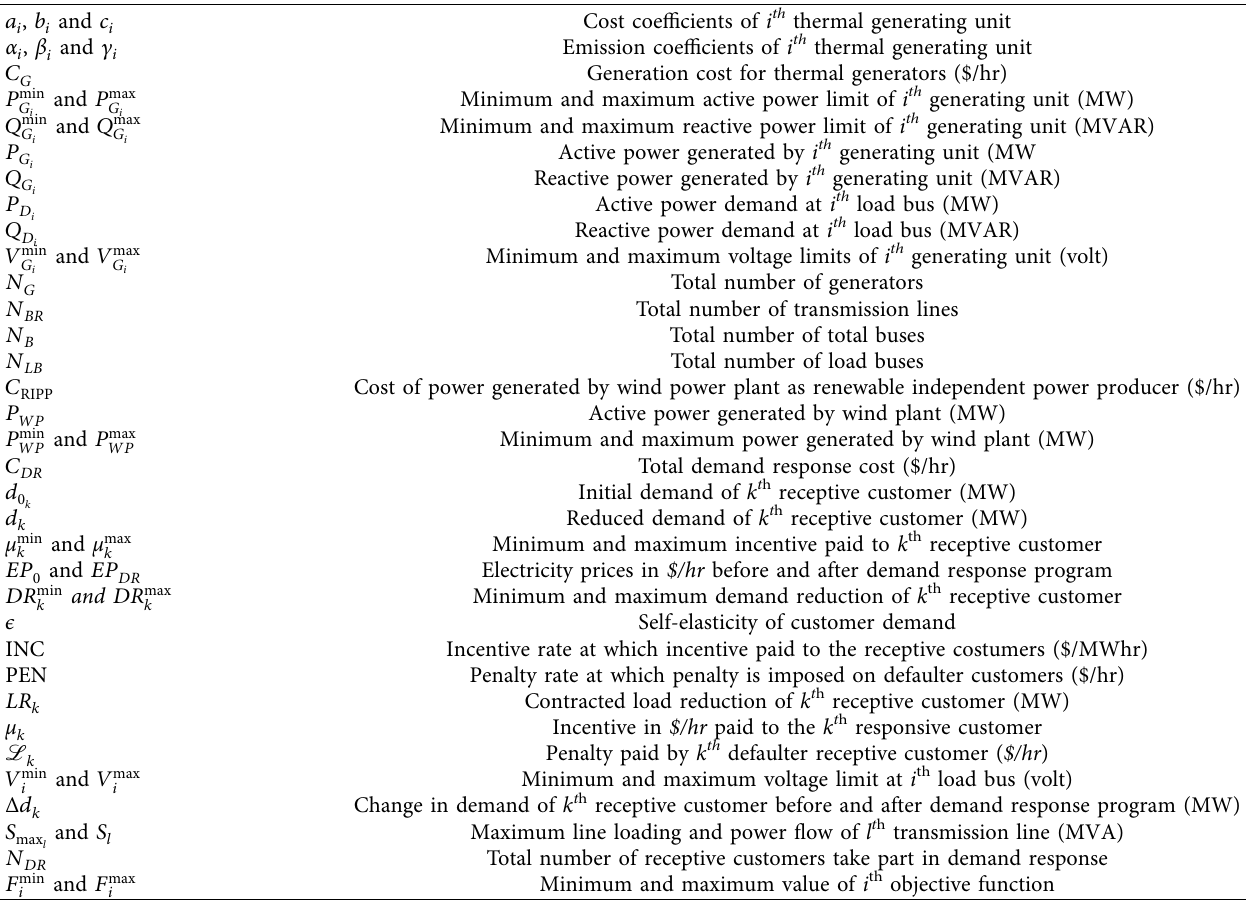
Table 18: Nomenclature.